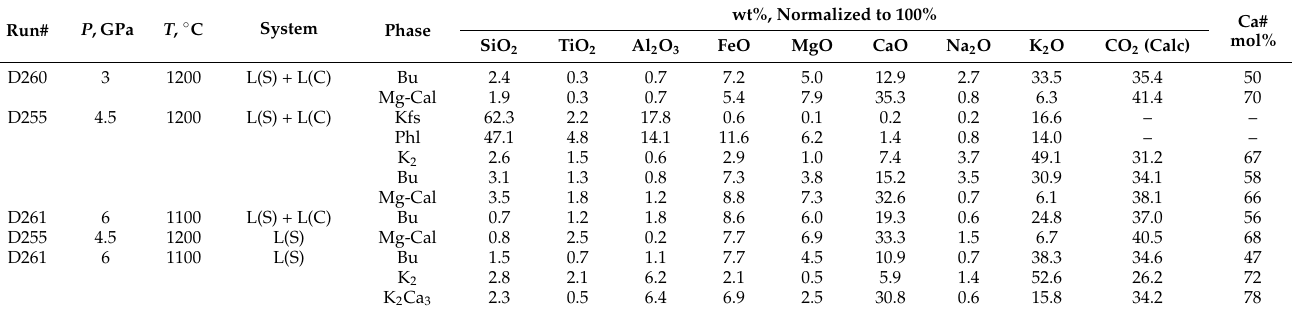
Table 7. Composition of quench products of carbonate